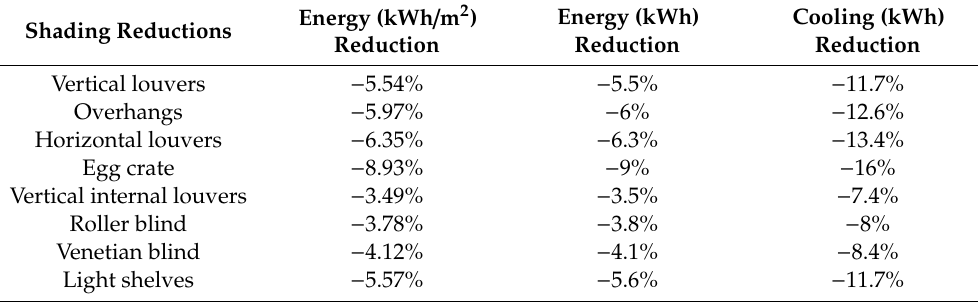
Table 10. Reduction by percent for energy and cooling loads.